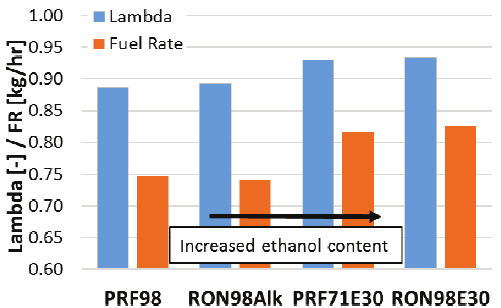
Fig. 2. Lambda and fuel rate (FR) at RON rating conditions for each fuel Due to a combination of increased fuel rate and higher heat of vaporization (HoV), the E30 fuels had a significant- ly reduced mixture temperature entering the intake port (downstream of the carburetor) during RON rating. Fig. 3 shows the reduction in mixture temperature by 8 to 13°C, from the iso-paraffinic fuels to the E30 fuels. While the HoV of the RON98E30 was higher than the PRF71E30, it is likely that the differences in the pre-ethanol fuel blends did not allow for all of the fuel components to be complete- ly evaporated before entering the intake port. This can also be observed in the lower temperature reduction between upstream and downstream of the carburetor (Carb. ∆ T) for the RON98E30 fuel. Work by Foong has gone into greater detail in analyzing the effects of increased ethanol and HoV on the RON rating method because of this reduction to the Fig. 1. ASTM knockmeter readings for lambda sweep from 0.8 to 1.0 for mixture temperature entering the engine [5–7]. each fuel